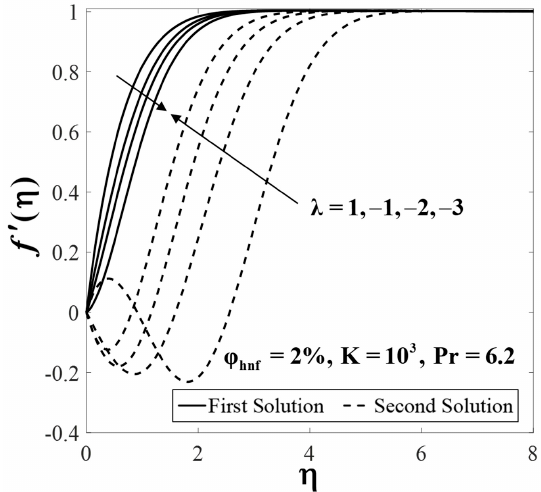
Figure 4. Velocity profiles 𝑓′(𝜂) for different values of 𝜆 .